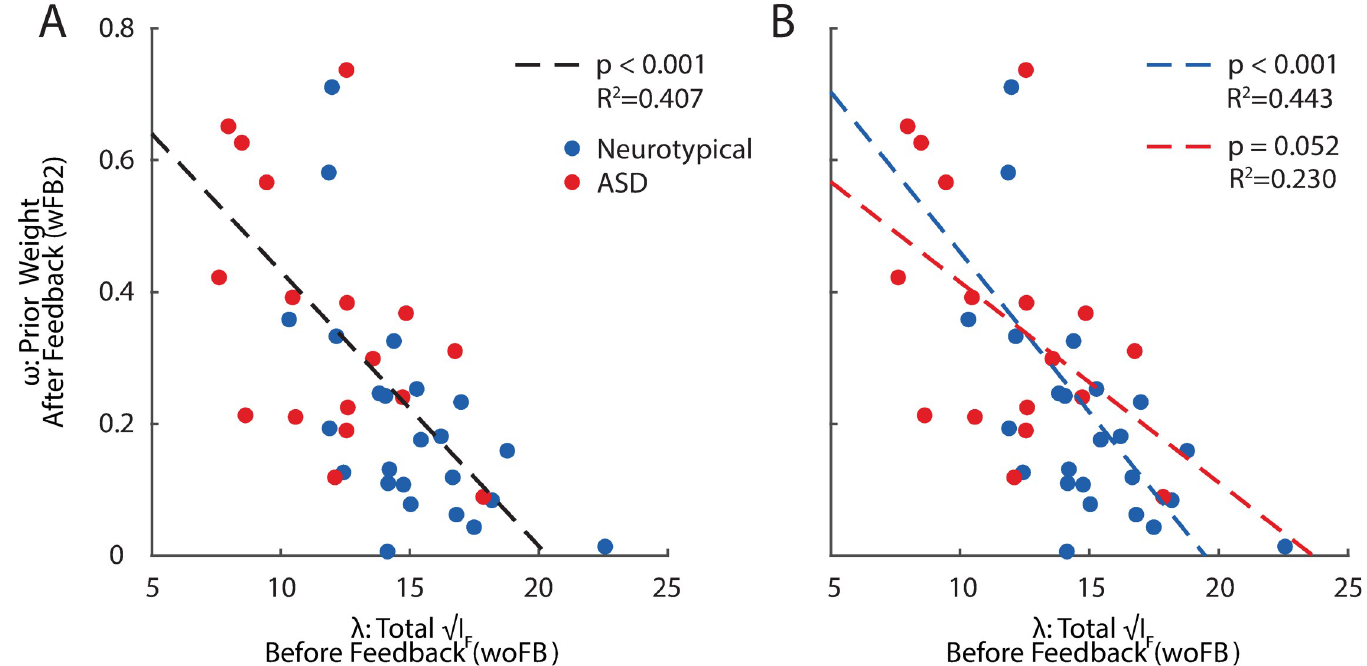
Fig 5. Correlation between sensory encoding capacity and flexibility in encoding resources allocation. (A) The flatness of FI after feedback (y-axis, indicating incorporation of stimulus statistics from the experiment) correlates strongly with total encoding resources before feedback (x-axis). The blue dots indicate individual neurotypical participants, and red dots indicate individual ASD participants. ( B) The same correlation holds within both the neurotypical and ASD groups. Raw data and code underlying this figure can be found at S1 Code , and numerical values that make up this figure can be found at S5 Data . ASD, autism spectrum disorder; FI, Fisher